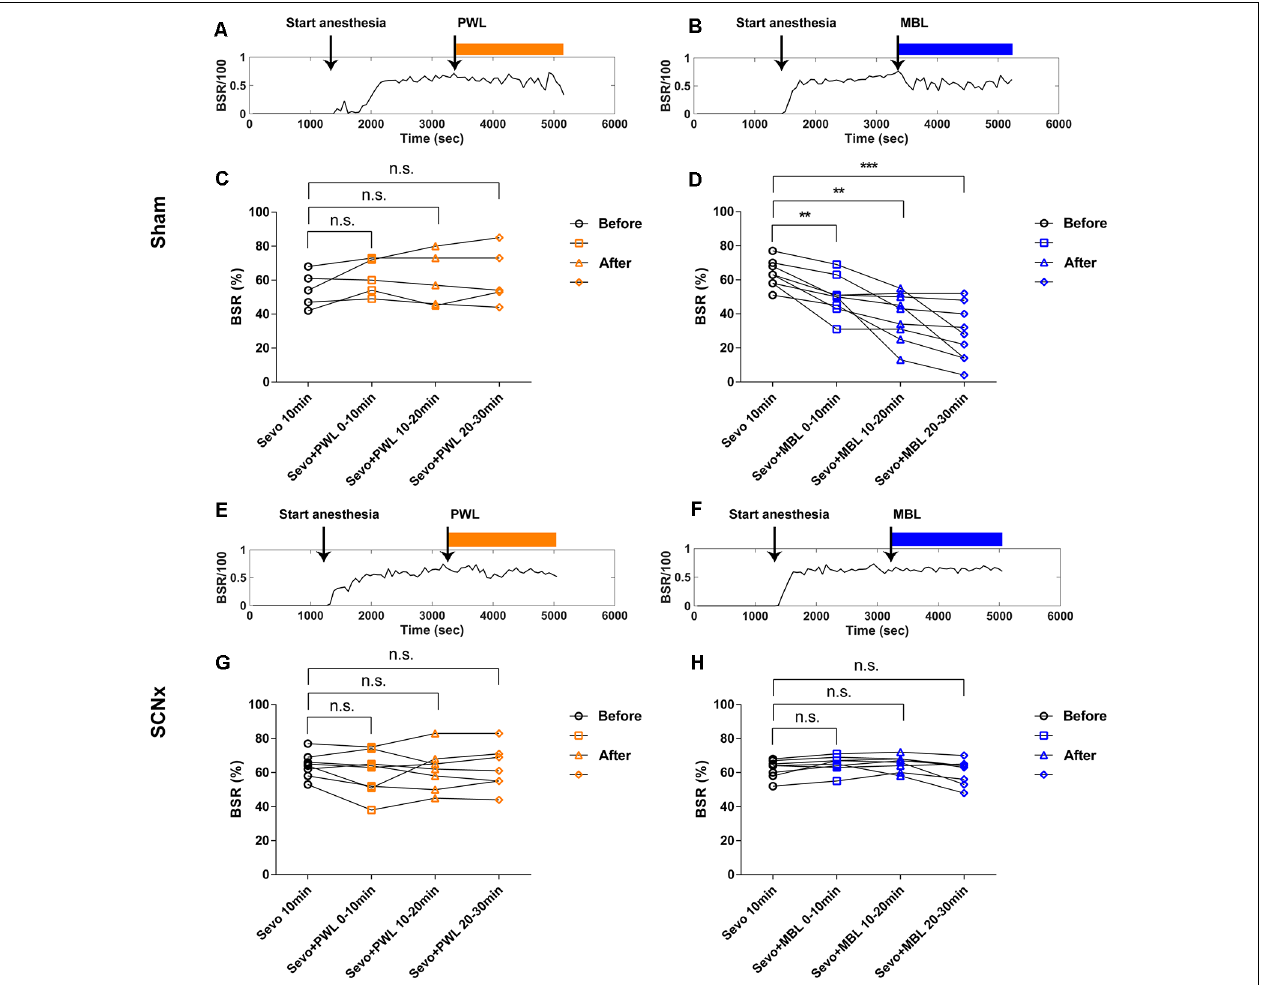
FIGURE 5 | Lesion of SCN neurons reversed the decrease of the burst suppression ratio induced by MBL during continuous inhalation of 2.5% sevoflurane. (A,B) Typical examples of the BSR response under sevoflurane anesthesia in the sham group-administered PWL (A) or MBL (B) . The orange and blue boxes indicate the duration of light exposure. (C,D) Effect of PWL (C) and MBL (D) on the electroencephalogram BSR during continuous inhalation of 2.5% sevoflurane in the sham group. The sham mice treated with MBL showed a significant 21% decrease (**) in the BSR during the first 10 min post-MBL and a 39% decrease (**) during the second 10 min post-MBL and a 56% decrease (***) during the last 10 min post-MBL compared to the sham pre-MBL 10 min (** p < 0.01 and *** p < 0.001 compared with sham pre-MBL 10 min, n = 9, RM one-way ANOVA, and Tukey’s multiple comparisons test with the Greenhouse-Geisser correction, F (1.765,14.12) = 23.07). However, the sham-PWL-treated animals showed no significant difference in the BSR compared to sham pre-PWL (n.s. = not significant, compared with sham pre-PWL 10 min, n = 5, RM one-way ANOVA, and Tukey’s multiple comparisons test with the Greenhouse-Geisser correction, F (1.180,4.719) = 1.340). (E,F) Typical examples of the BSR response under sevoflurane anesthesia in the SCNx group-administered PWL (E) or MBL (F) . The orange and blue boxes indicate the duration of light exposure. (G,H) Effect of PWL (G) and MBL (H) on electroencephalogram BSR during continuous inhalation of 2.5% sevoflurane in the SCNx group. The SCNx mice treated with MBL showed no significant difference in BSR compared to the SCNx pre-MBL 10 min (n.s. = not significant compared with SCNx pre-MBL 10 min, n = 8, RM one-way ANOVA, and Tukey’s multiple comparisons test with the Greenhouse-Geisser correction, F (1.550,10.85) = 3.516). SCNx PWL-treated animals showed no significant difference in the BSR compared to SCNx pre-PWL (n.s. = not significant compared with SCNx pre-PWL 10 min, n = 8, RM one-way ANOVA, and Tukey’s multiple comparisons test with the Greenhouse-Geisser correction, F (1.775,12.42) = 1.005).